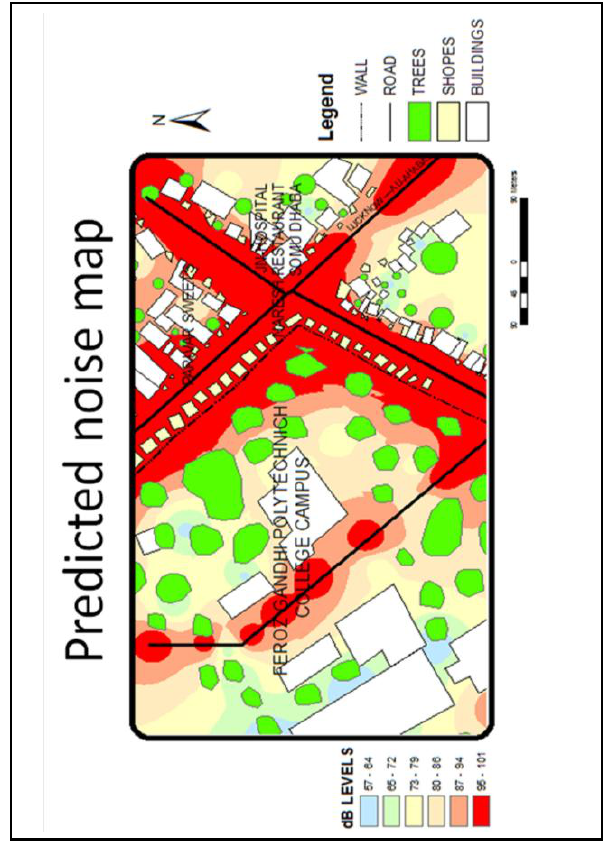
Figure 4. Google Image for RGIPT, AB1, and AB2 where Wall Act as a Barrier between Railways track and building